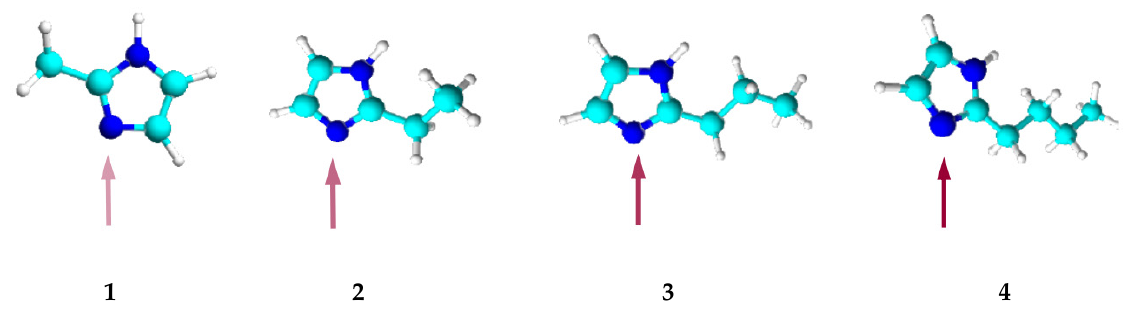
Figure 3. Models of the 2-alkylimidazole molecule, 2-methylimidazole ( 1 ), 2-ethylimidazole ( 2 ), 2-propylimidazole ( 3 ), and 2-butylimidazole ( 4 ).